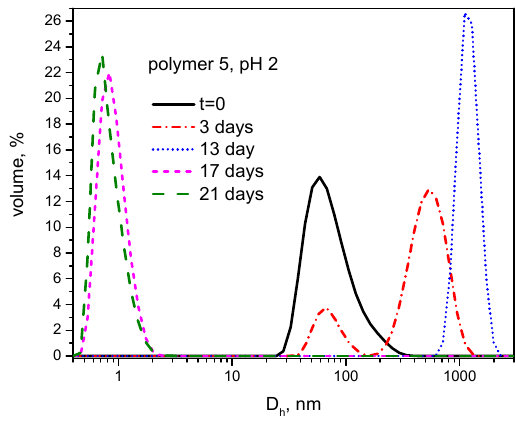
Figure 6. Size distribution by volume measured by dynamic light scattering for polymer 5 in citrate/phosphate buffer at pH 2 at various time points (polymer concentration—1 mg/mL, D h —hydrodynamic diameter).